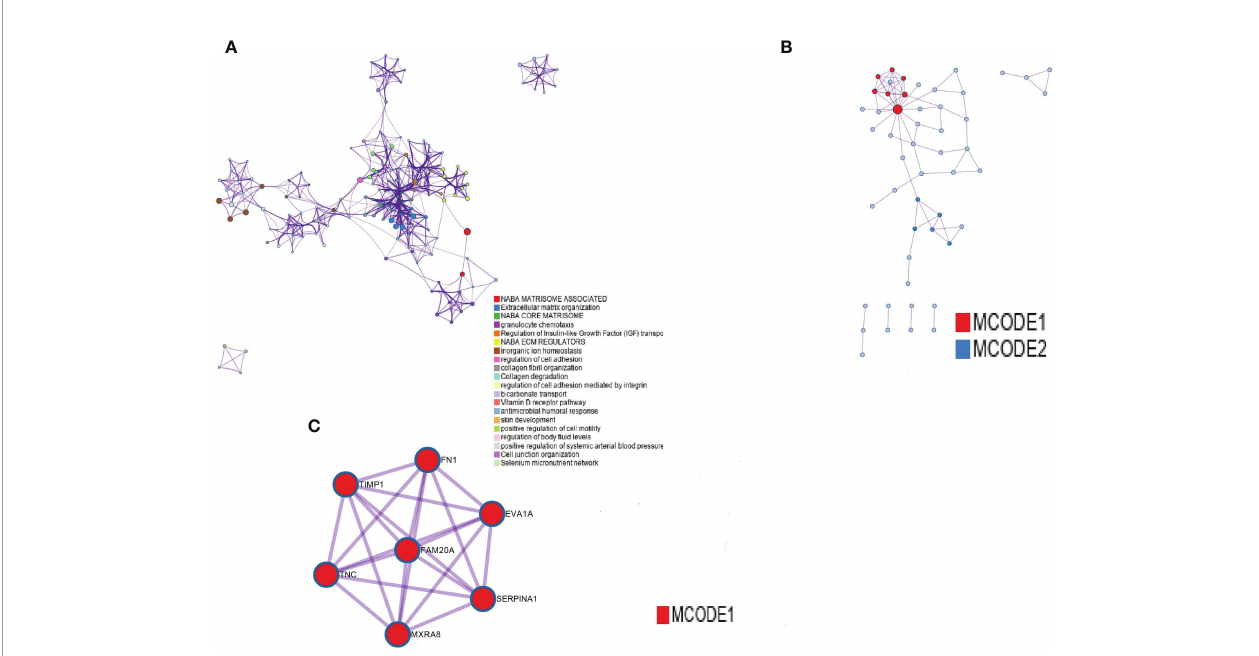
FIGURE 2 | PPI network construction. (A) PPI networks of differentially expressed genes between the presence and absence of lymphatic metastasis. (B) The fi rst seven hub genes, with nodes of higher degree shown in bright red. (C) The seven marked red